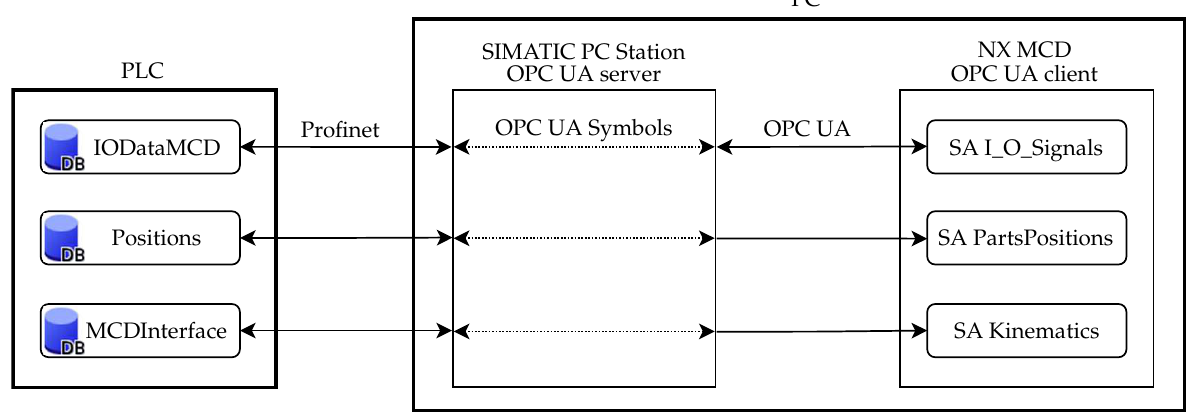
Figure 9. Digital twin of the delta robot manipulator designed in NX MCD environment.